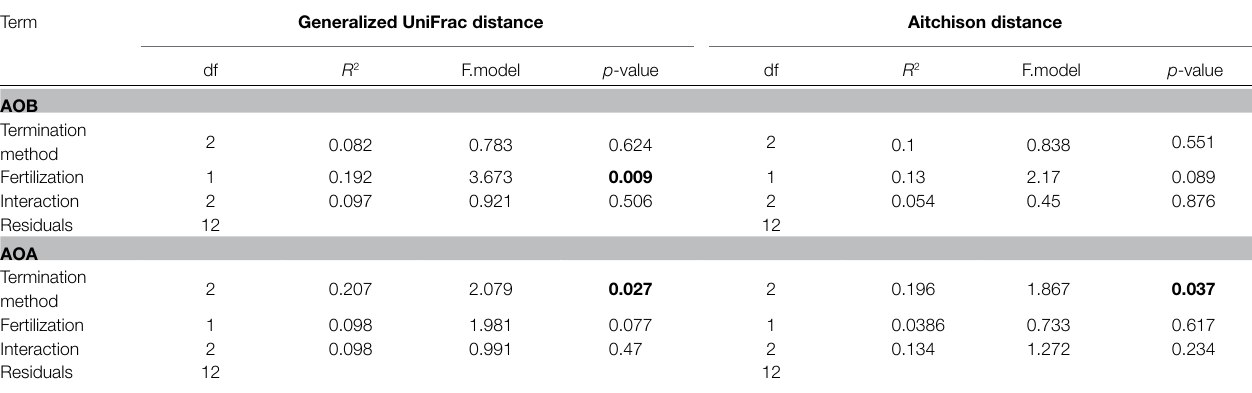
TABLE 3 | Beta-diversity of ammonia-oxidizing bacteria (AOB) and ammonia-oxidizing archaea (AOA) communities.